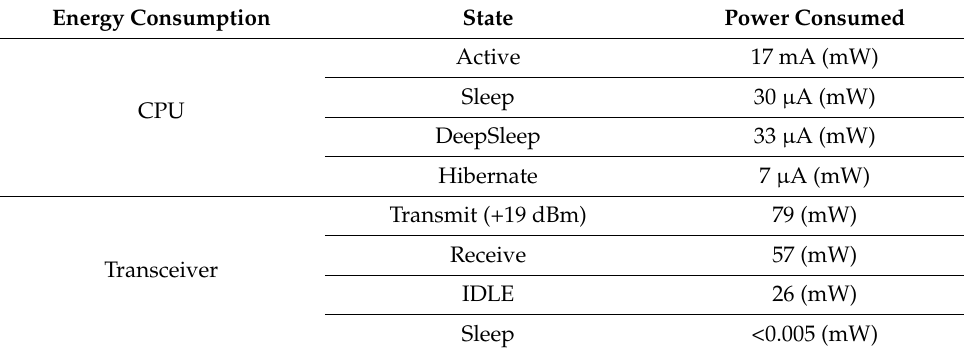
Table 2. Waspmote